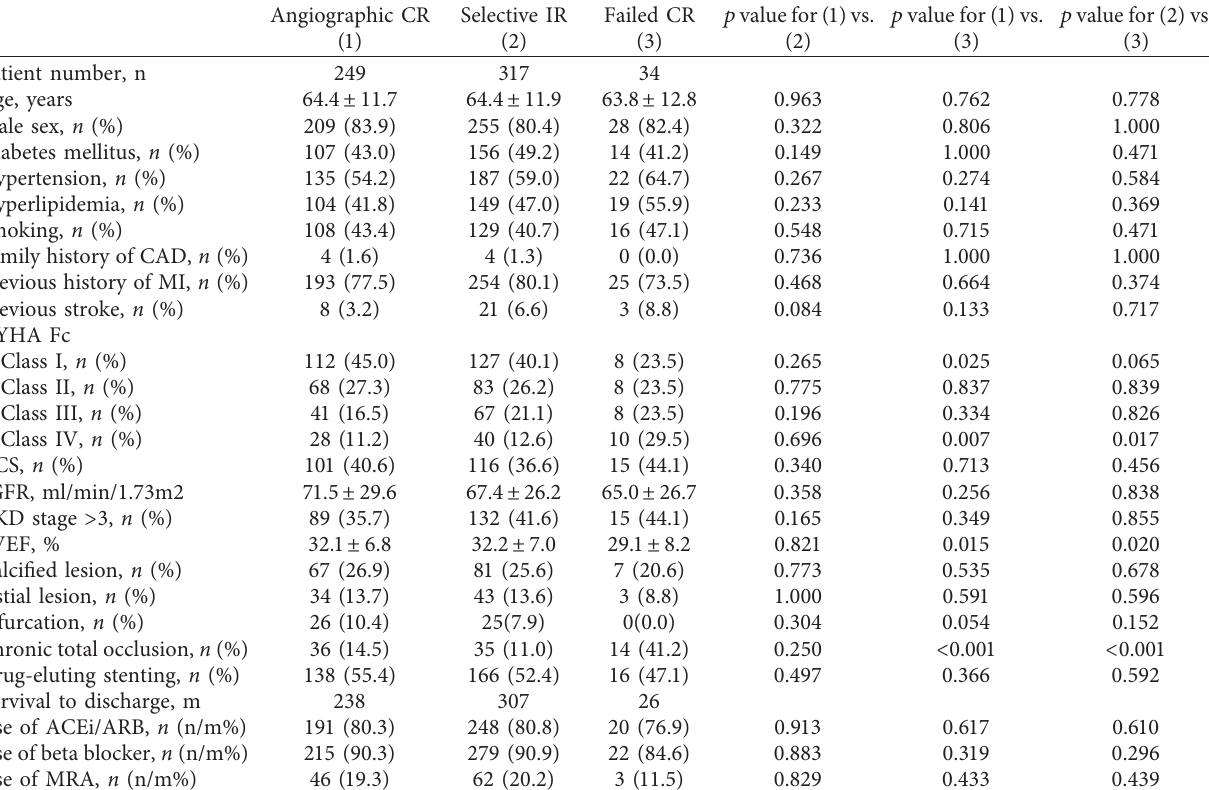
Table 1: Baseline characteristics of heart failure patients with multivessel disease according to final angiographic